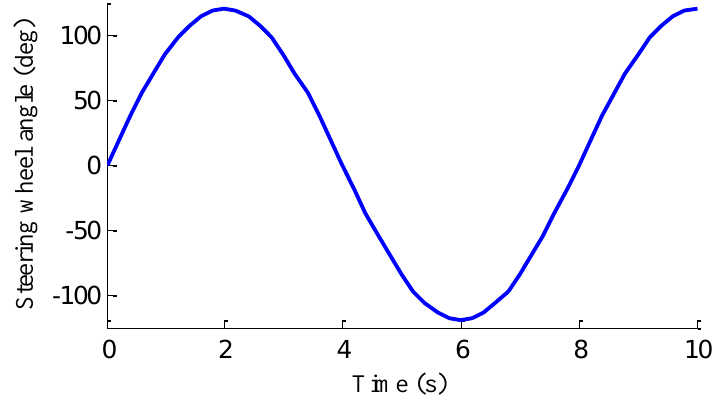
Figure 6. Steering wheel angle during the sine steer manoeuvre.